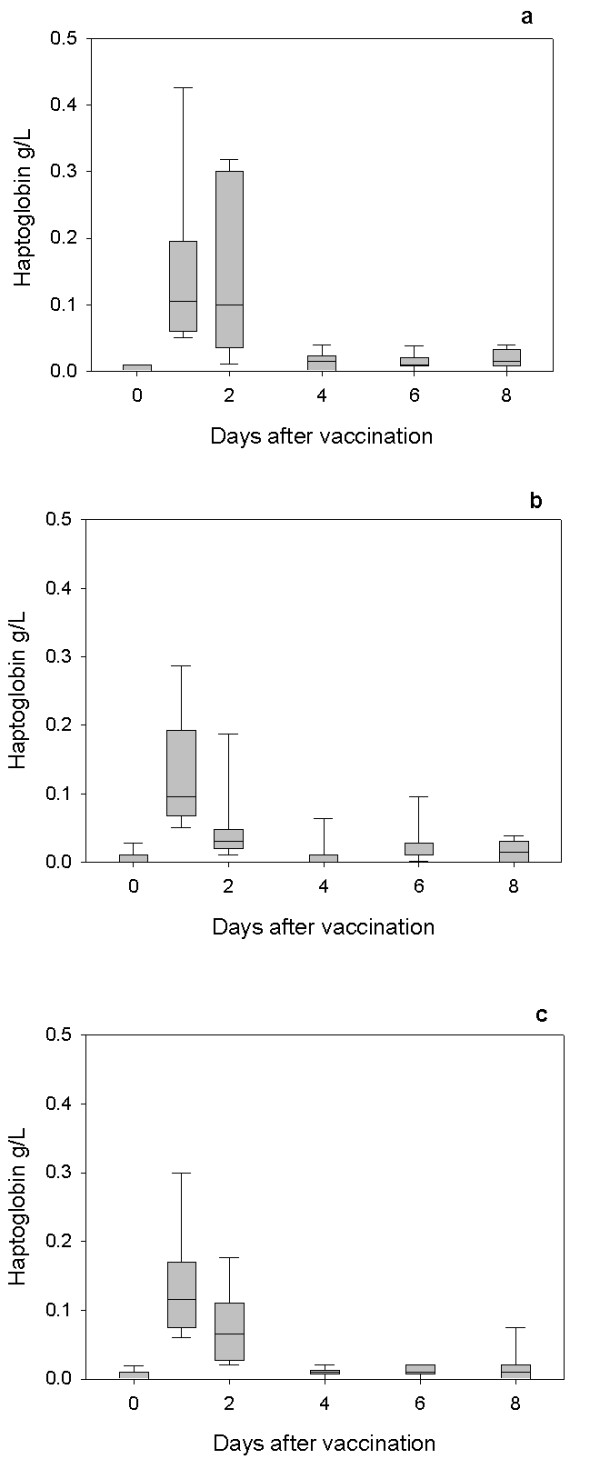
Hp response to the first vaccination with Heptavac. The concentrations of haptoglobin in lambs (n = 10) following the first vaccination with Heptavac. The maternal diets of the lambs were High/High (a), High/Low (b) and Low/High (c). The plots show the median as the line in the box, the 25th and 75th percentile are represented by the box with the whiskers representing the 10th and 90th percentiles.